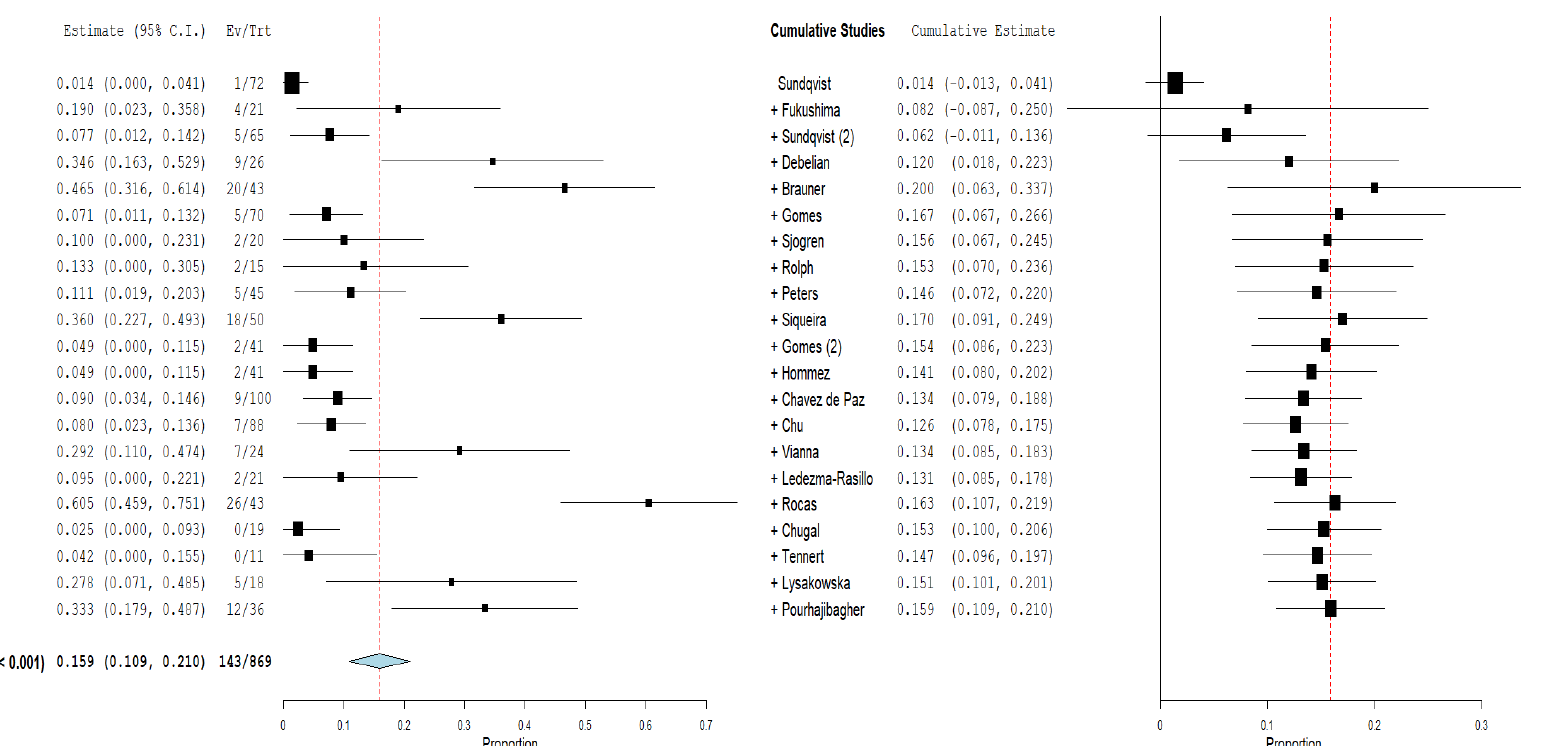
ff ects model of the meta-analysis cumulative of the primary outcome subgroup Figure 4. Forest plot of the random effects model of the meta-analysis cumulative of the primary outcome subgroup A. Figure 4. Forest plot of the random e